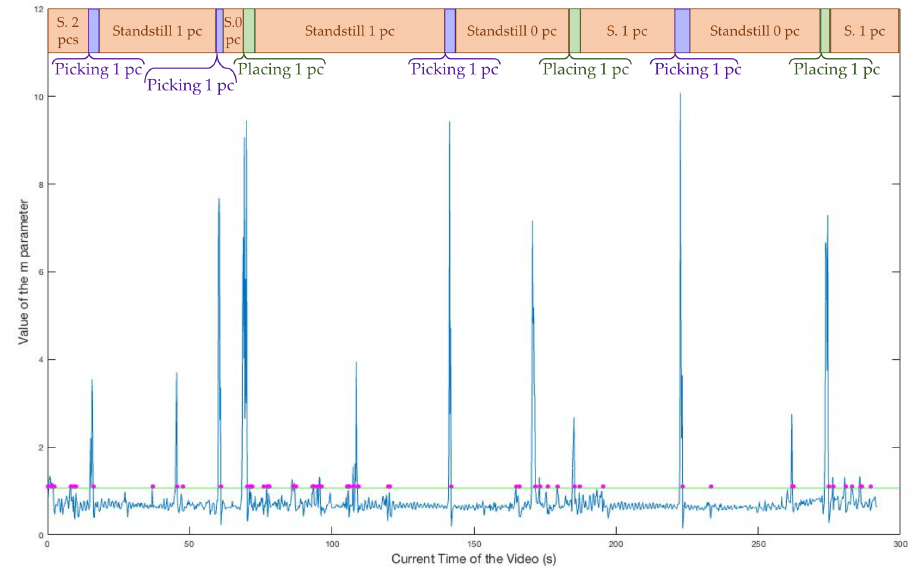
Figure 11. Plot of the m parameter regarding a video collected before the light ring